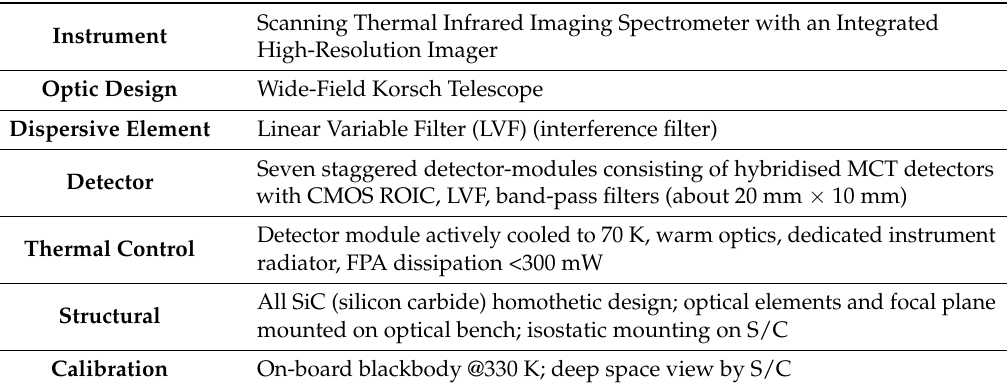
Table 3. HiTeSEM instrument concept.